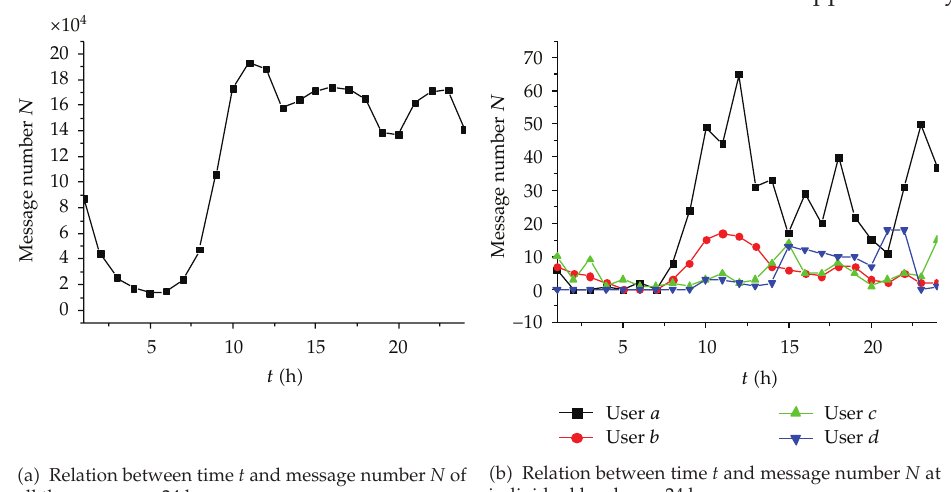
Figure 3: Message data over 24 hour. Note: “1” on the x -axis means from “0” to “1” o’clock, “2” means from “1” to “2”, and so on.